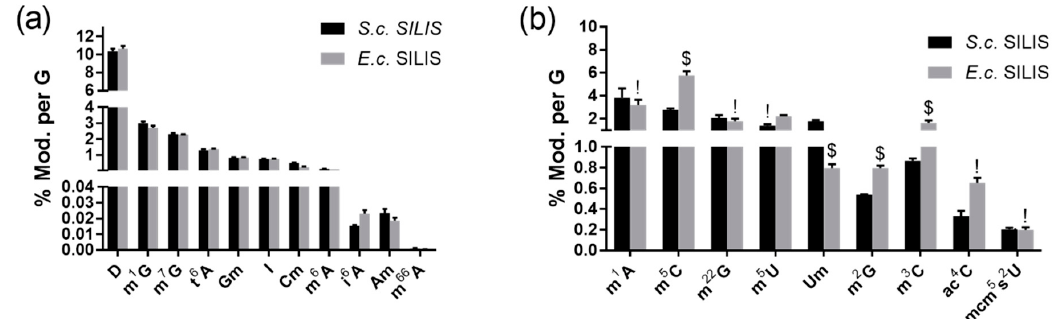
Figure 4. Quantification of modified (Mod.) nucleosides in tRNA from HEK 293T cells using either the S. c. SILIS or the E. c. SILIS. The average of three technical replicates is shown. The error bars reflect the standard deviation. ( a ) Modified nucleosides that are present in both SILISs. ( b ) Modified nucleosides, that are only present in the S. c. SILIS and not in the E. c. SILIS. For quantification of nucleosides absent in the E. c. SILIS, chemically similar SILIS analytes ($) or no SILIS analytes (!) (external calibration only) were used as detailed in the text.